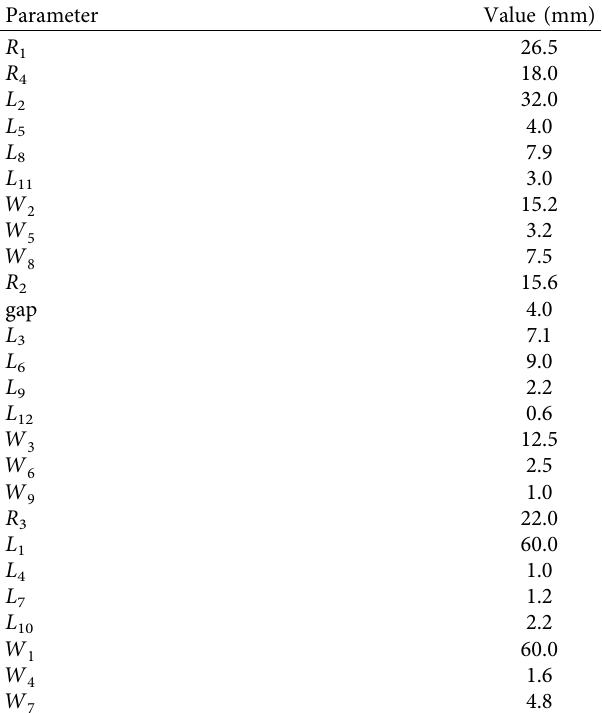
Table 1: Dimensions of the proposed antenna.